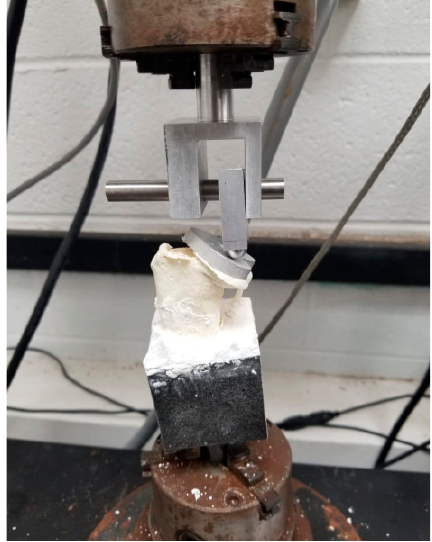
Figure 11. A collapsed sample from the static compression tests. A significant deformation occurred before the failure of the samples.